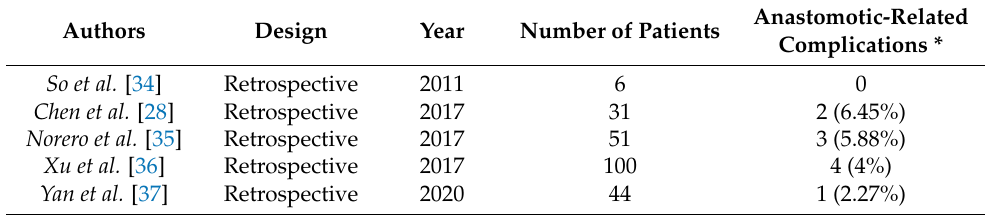
Table 4. Comparison of previous